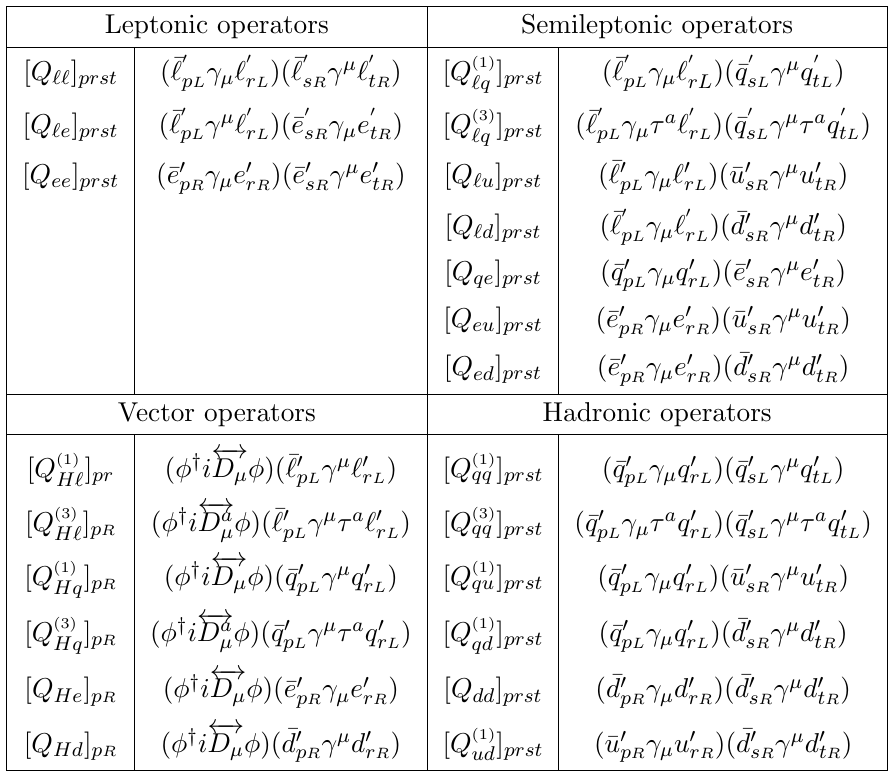
Table 1 . SU(2) (cid:2) U(1) invariant operators involved in the renormalization group evolution of L Y L 0 from (cid:3) to the EW scale. We adopt the same notation as in [32]. NP L 0 NP